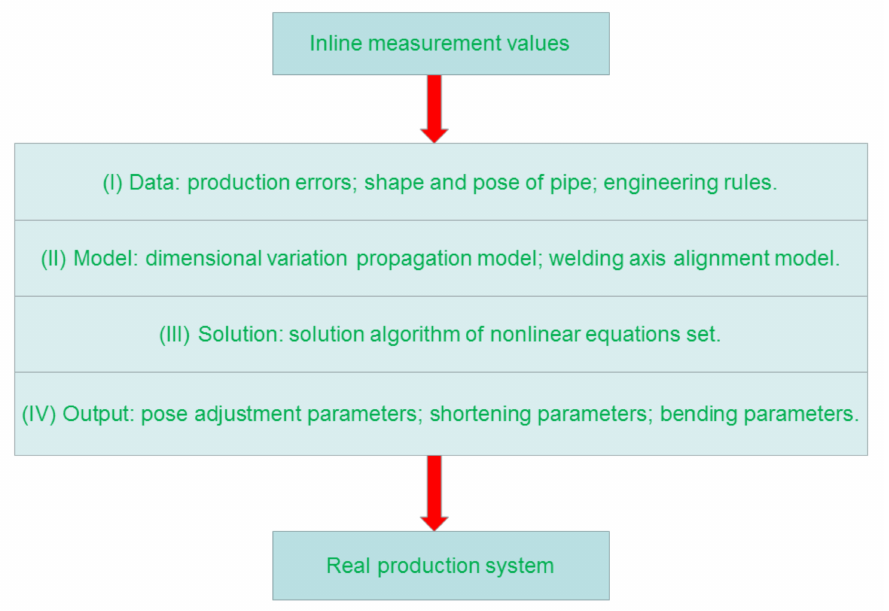
Figure 3. Adaptive control system of adjustable